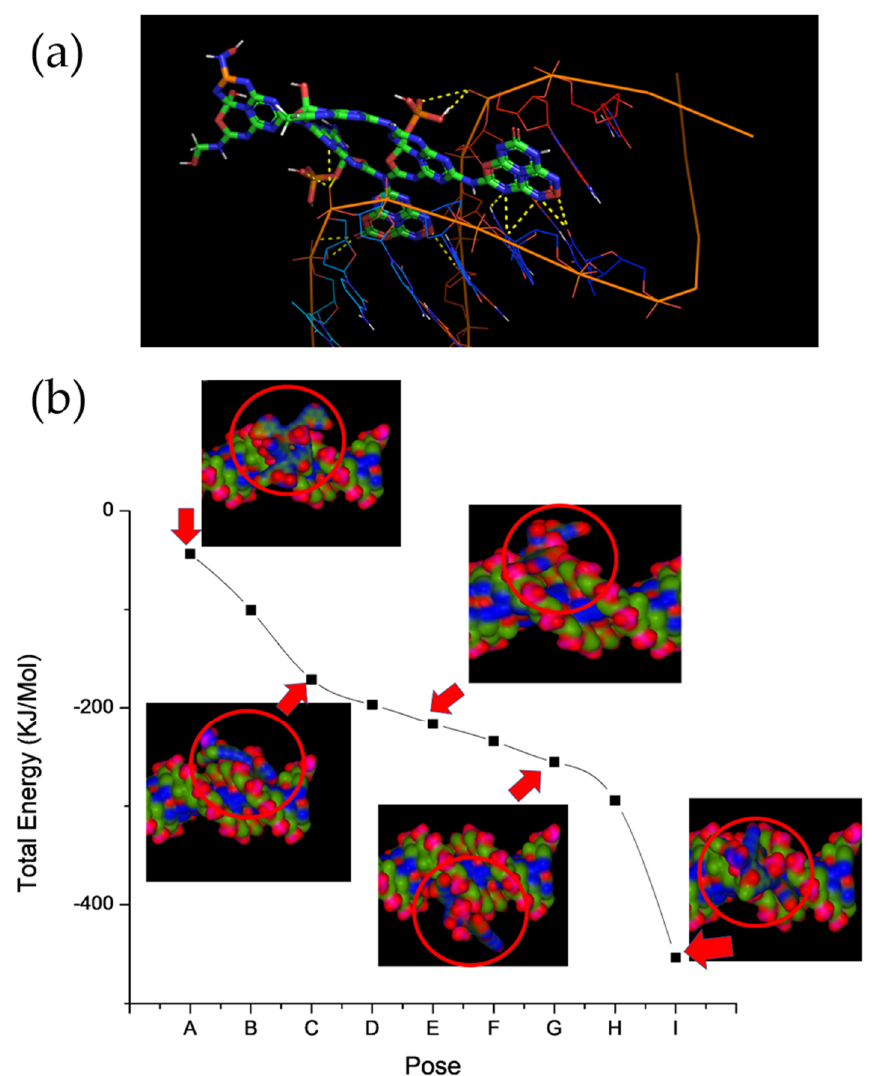
Figure 9. ( a ) Molecular Docking between a small DNA sequence, defined as a receptor, and a modeled g-POCN fragment, defined as a ligand (the most stable pose). ( b ) The energies calculated for different poses between the g-POCN fragment and the dsDNA.